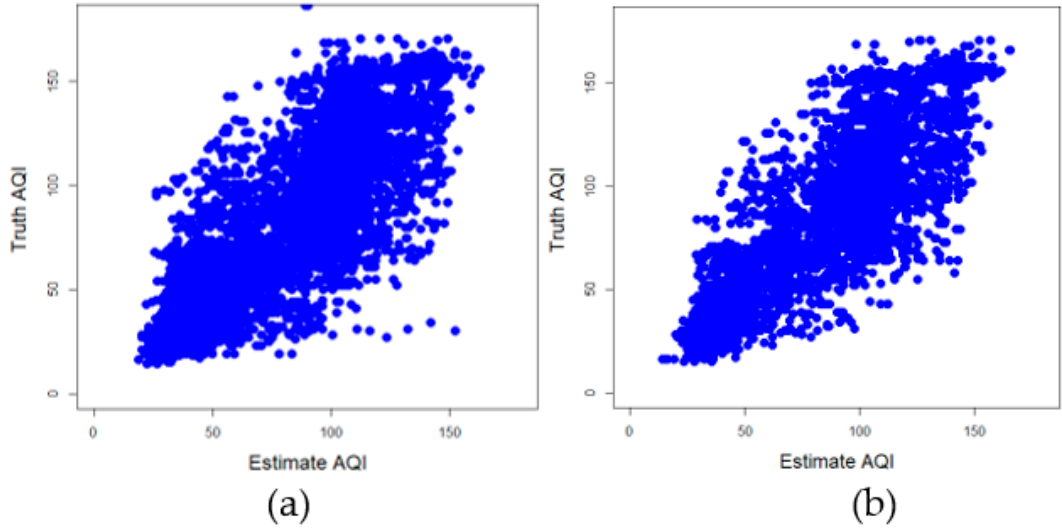
Figure 15. The relationship between the estimated and actual AQI when the ratio of training-to-test is 7:3; ( a ) invalid data is not excluded, ( b ) invalid data is excluded.